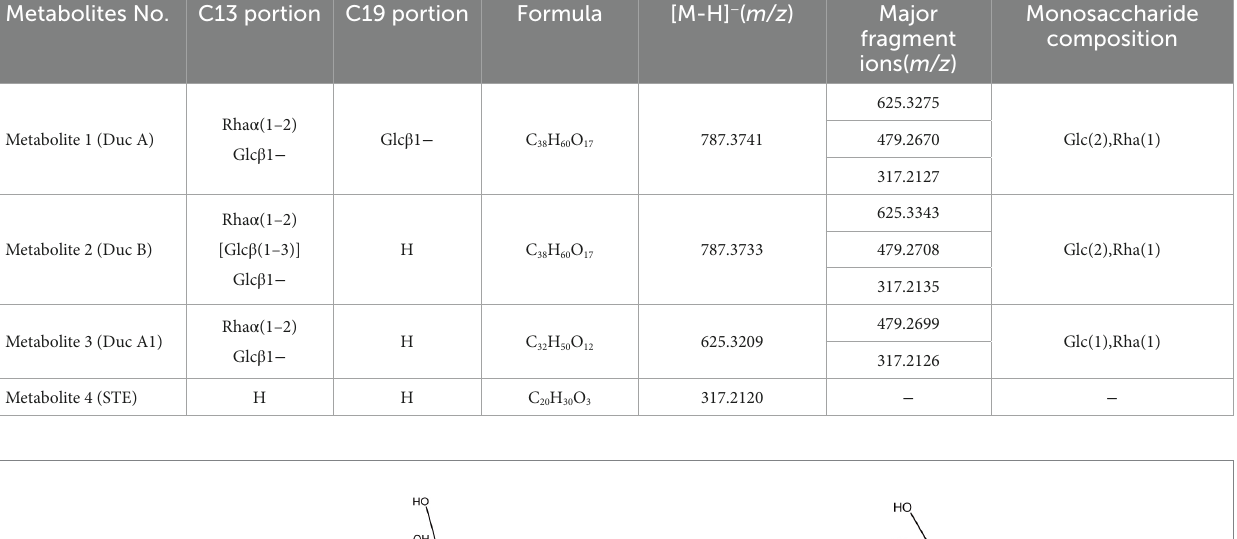
TABLE 1 Formula and MS fragmentation of metabolites. Metabolites No.